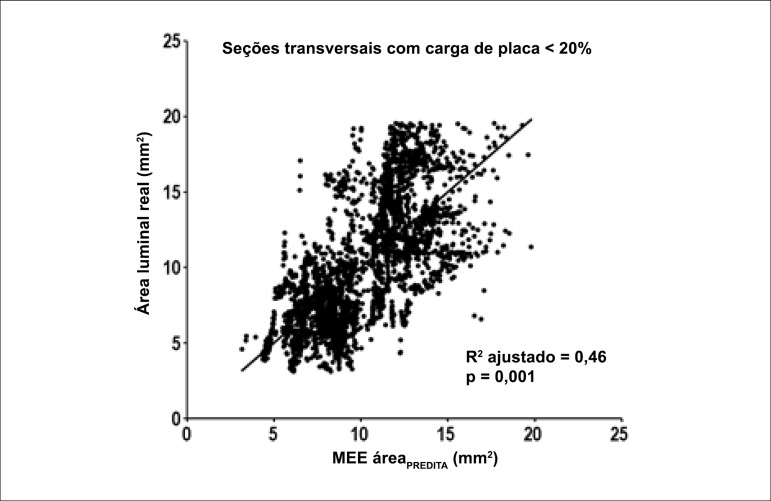
Scatter correlation graph between estimated normal external elastic membrane area
(EEM areaPREDICTED) and the actual lumen area in cross-sections with
absent or trivial plaque (plaque burden < 20%).